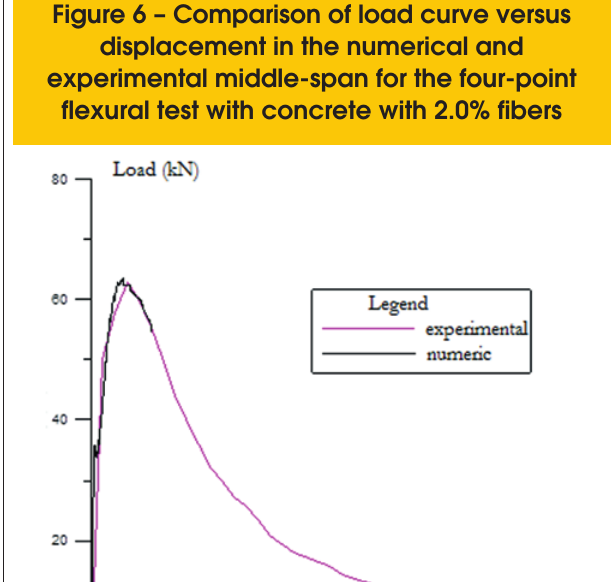
Figure 5 – Comparison of load curve versus displacement in the numerical and experimental middle-span for the four-point flexural test with concrete with 1.5% fibers